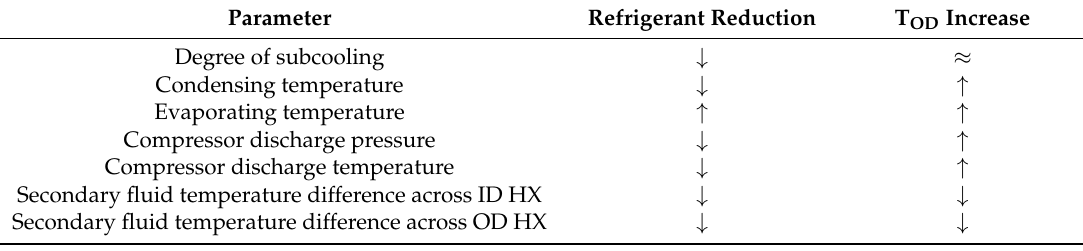
Table 2. Parameter trend and characteristics of the water-to-water heat pump in cooling mode.